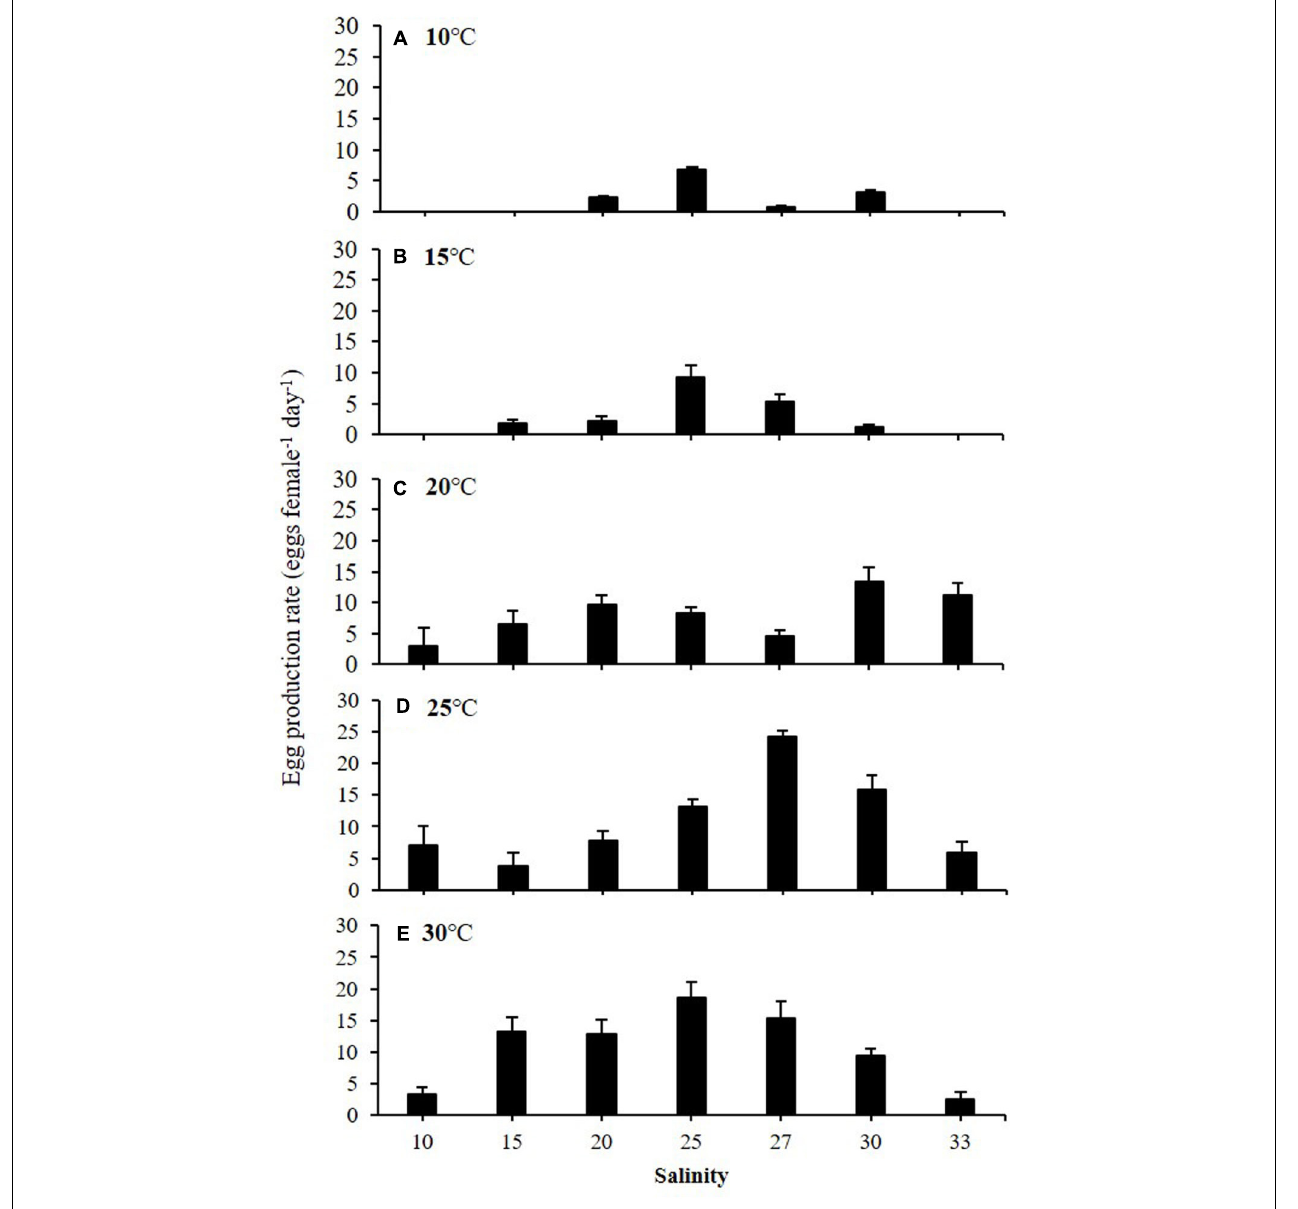
FIGURE 2 | Egg production rate (EPR) of adult female Acartia ohtsukai at each temperature and salinity. (A) 10 ◦ C, (B) 15 ◦ C, (C) 20 ◦ C, (D) 25 ◦ C, and (E) 30 ◦ C. Data are presented as mean ± standard error (SE). Different letters above the bars indicate significant differences ( p <